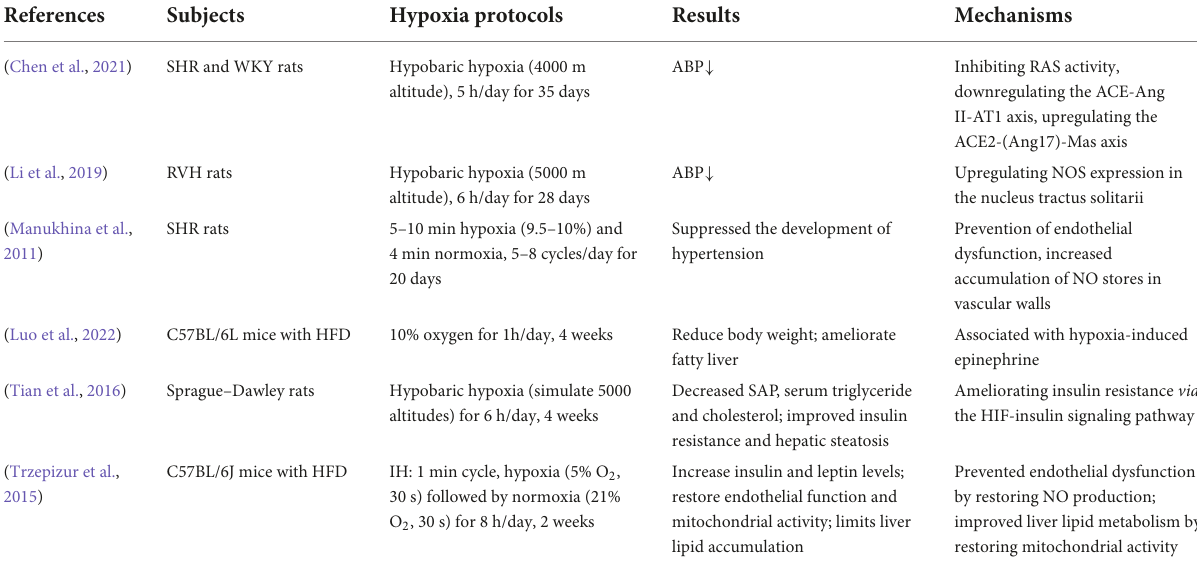
TABLE 2 Effects of intermittent hypoxia on vascular risk factors in